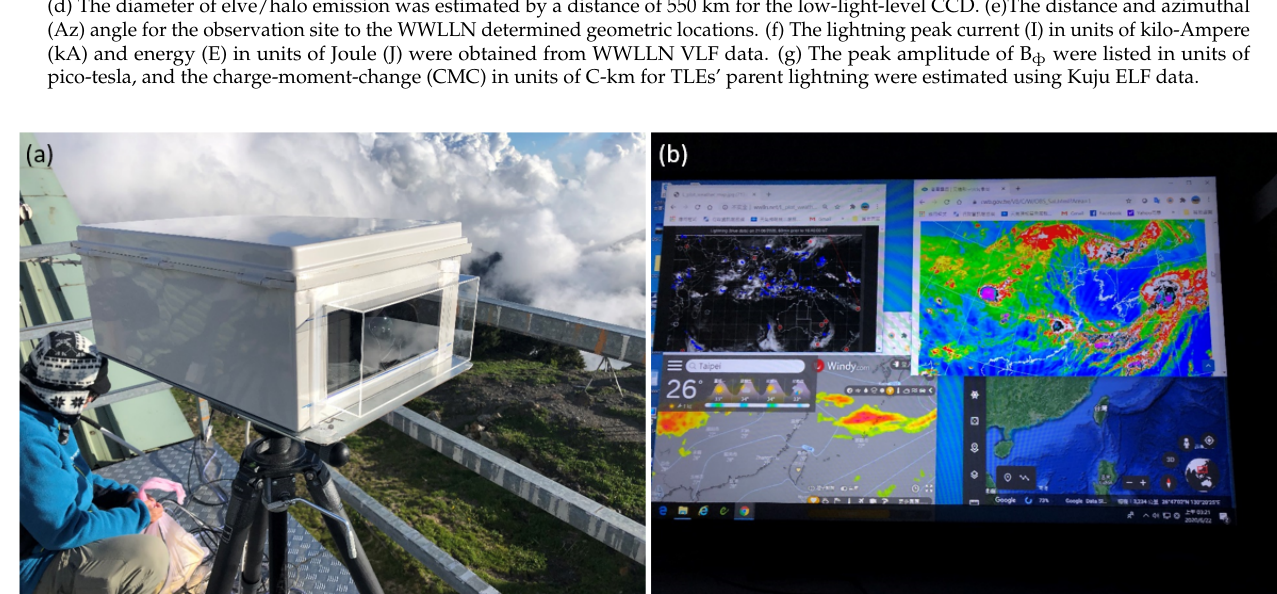
Table 1. The 2020 Taiwan campaign observed TLEs (two sprites, two elves, and two halos) on June 22.